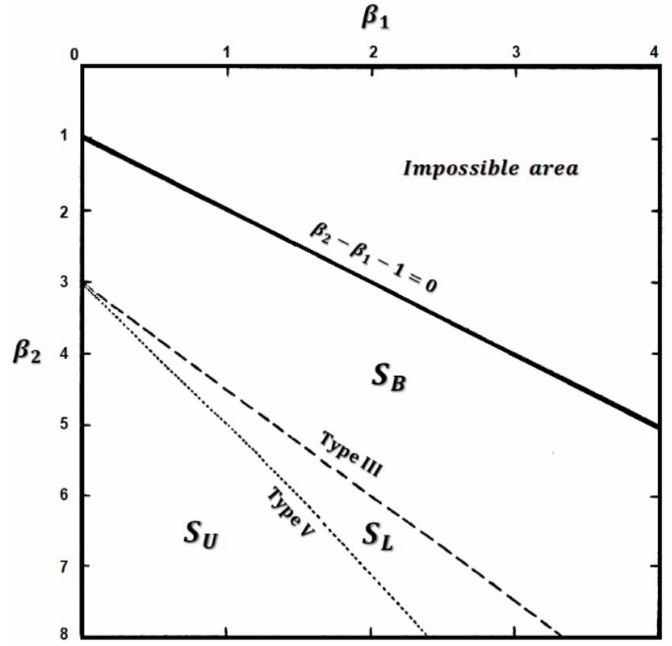
Figure 1. Regions of Johnson’s systems.